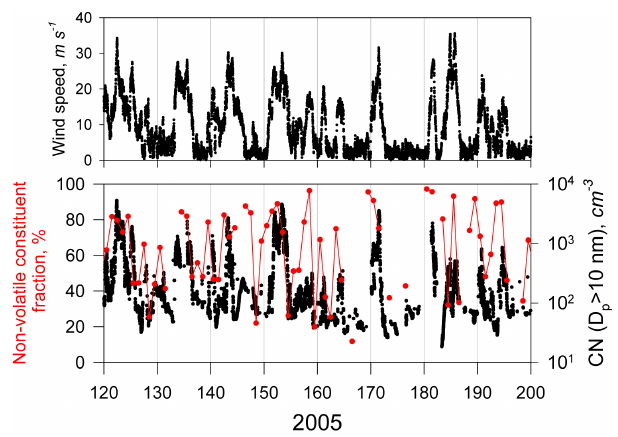
Fig. 9. Variations of hourly mean wind speed, hourly mean CN con- centration, and daily mean number fraction of non-volatile particles at Syowa Station during